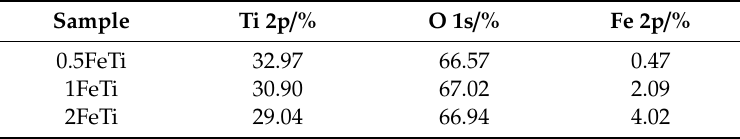
Table 1. Molar content of carbon-subtracted peak area in Figure